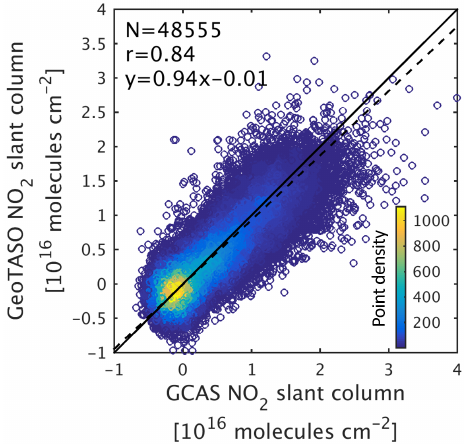
Figure 17. GCAS vs. GeoTASO retrieved NO 2 slant columns dur- ing the two morning 13 September 2013 Houston overpasses for nearest coincident observations within 10min and 500m. The black solid line represents the 1 : 1 ratio. The black dashed line represents a reduced major axis linear regression.